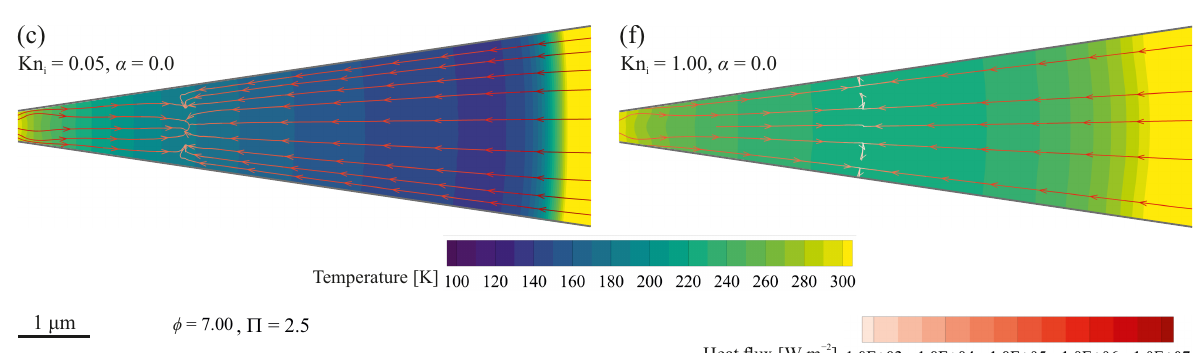
Figure 11. The influence of the tangential accommodation coefficient α on the thermal field (contours) and heat flow direction (coloured by the magnitude of heat flux). Π = 2.5 and φ =